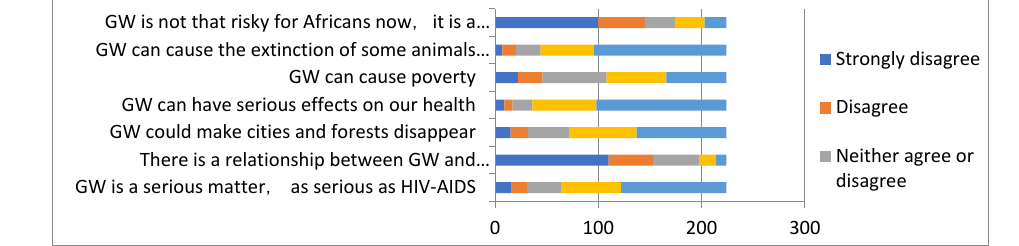
Fig. 5: Global Warming risks opinion Table 3: Descriptive statistics results on GW risks